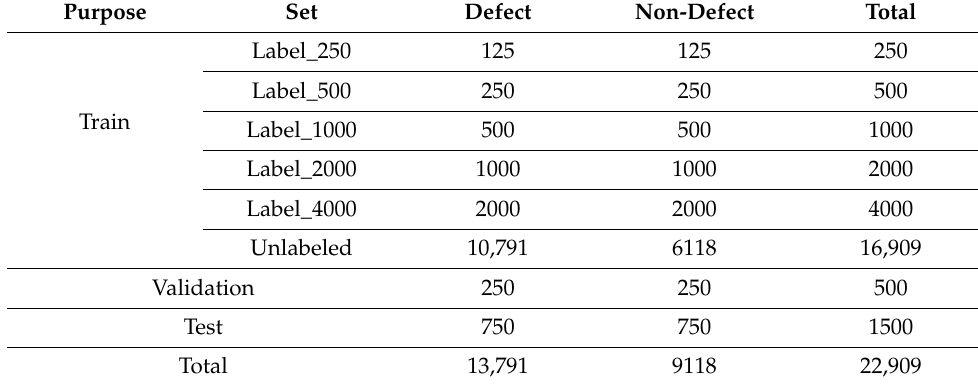
Table 1. Dataset used in this study.